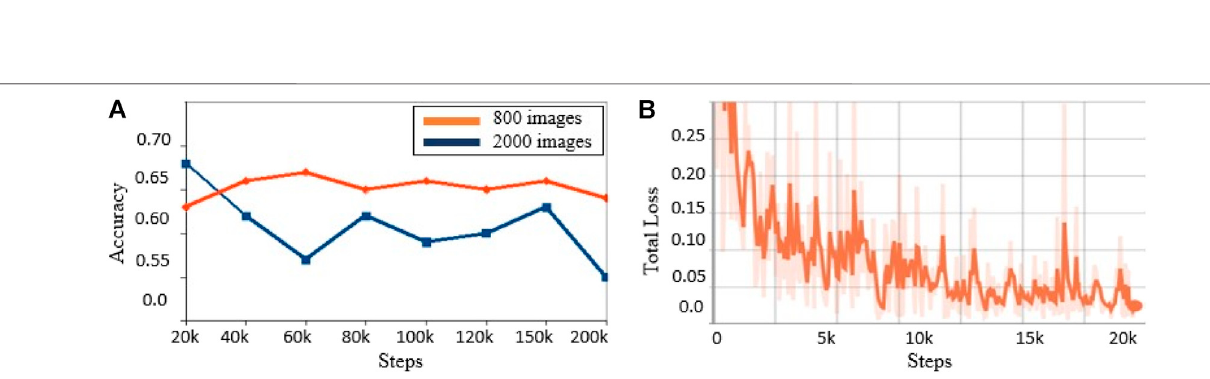
Frontiers in Robotics and AI |